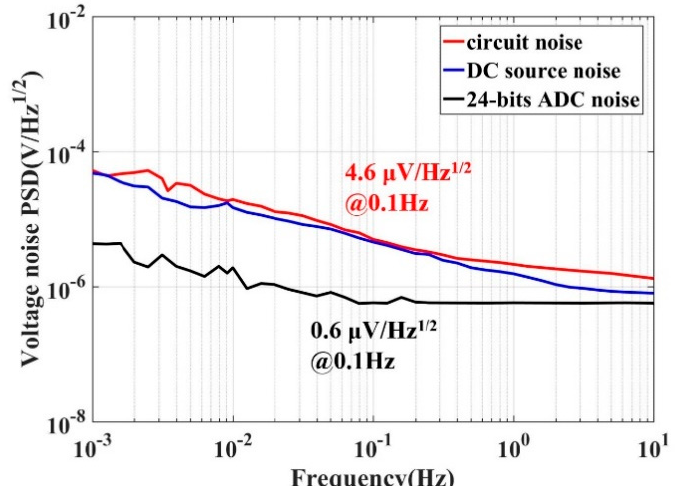
Figure 7. Comparing the noise of the voltage reference and the capacitive transducer at 0.1 Hz with the same maximum output of 5 V. The red line comes from the capacitive transducer and the blue one is caused by the DC source being kept constant at 4.6 μ V/Hz 1/2 at 0.1 Hz. The black line is the background noise of the 24-bit analog-digital converter